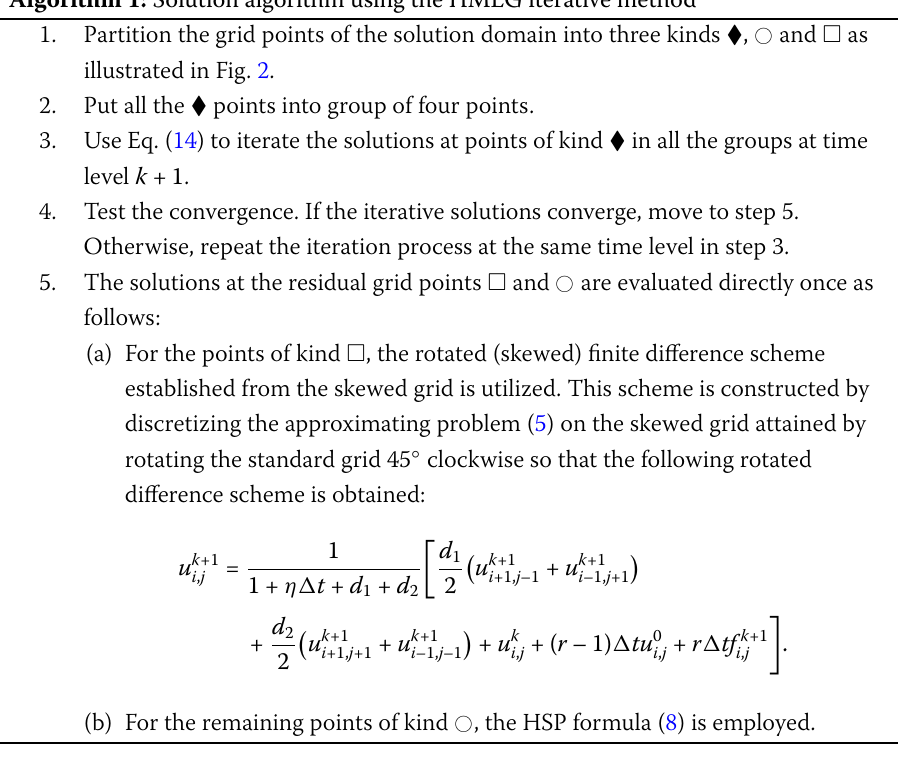
Algorithm 1: Solution algorithm using the HMEG iterative